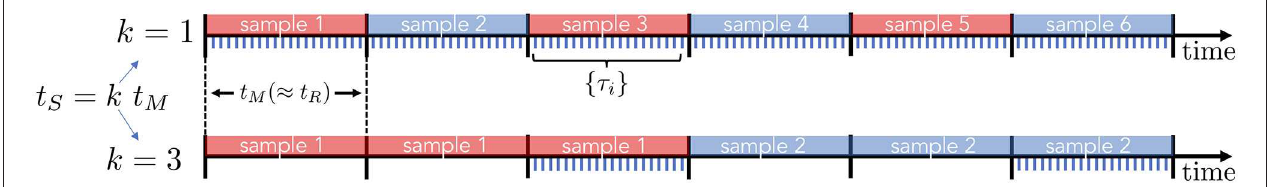
FIGURE 3 | Schematic of input and output timing, with t S the sample duration, t M the input mask duration and t R the roundtrip time. Input samples are injected during (integer) k roundtrips (bars in alternating colors) and the neural responses are recorded at times